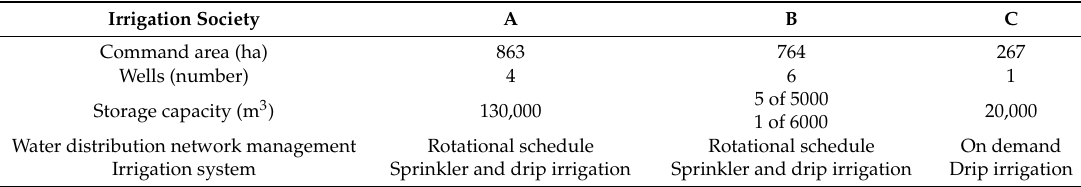
Table 1. Characteristics of the water user